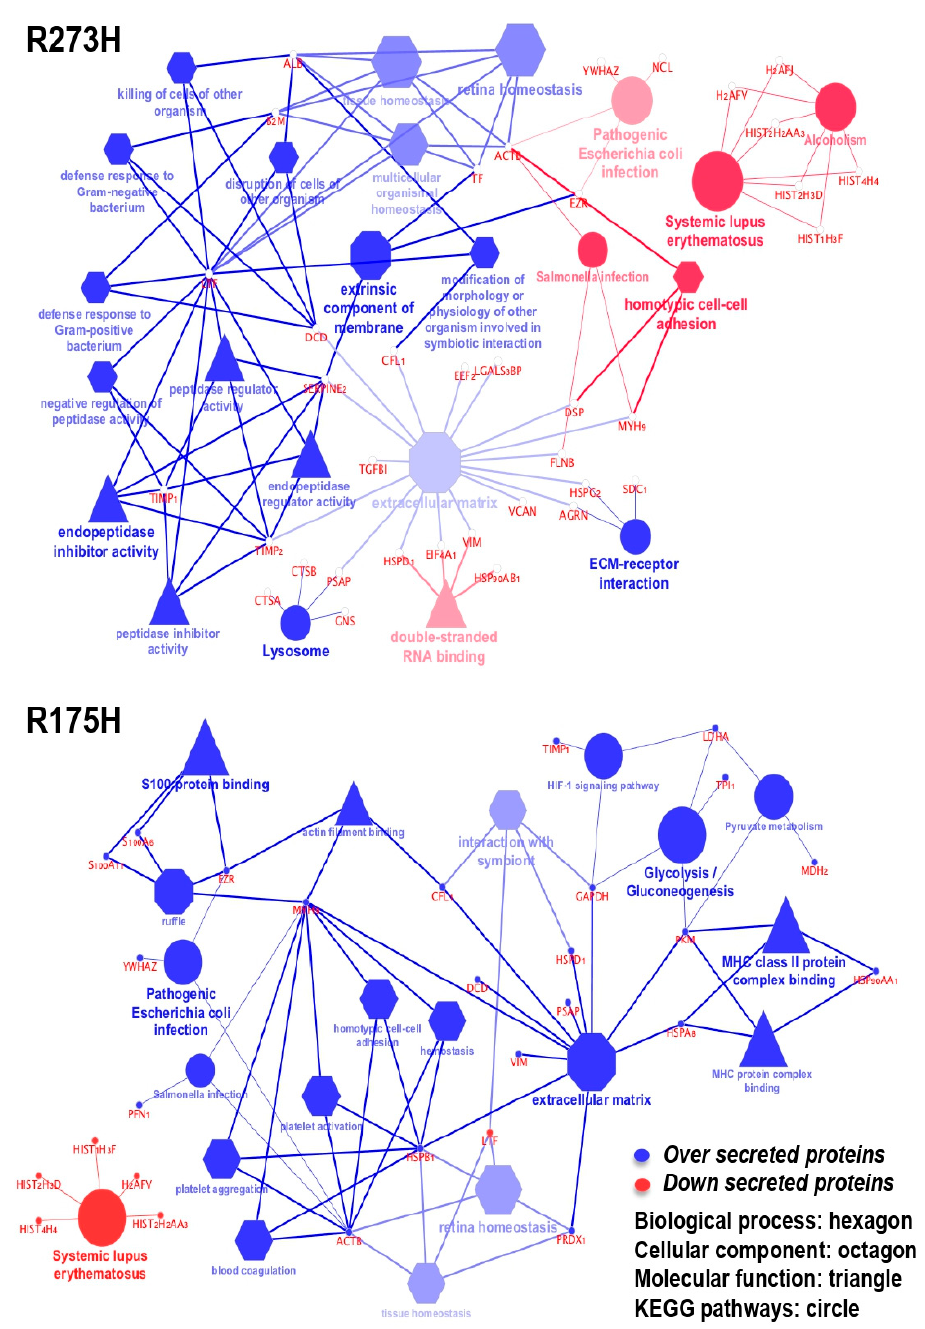
Figure 5. Cytoscape-based ClueGo / CluePedia pathway analysis and visualization. The enriched pathways were derived by the Kyoto Encyclopaedia of Genes and Genome (KEGG) database. The figure reports the functionally grouped networks of regulated proteins in the R273H and R175H transfected cell line. Blue term indicates an abundance increase compared to the mock control while red term indicates an abundance decrease. Terms are linked based on к- score ( ≥ 0.4), edge thickness indicates the association strength while node size corresponds to the statistical significance for each term. Biological processes are represented with hexagons, cellular components with octagons, molecular functions with triangles and KEEG pathways with circles.